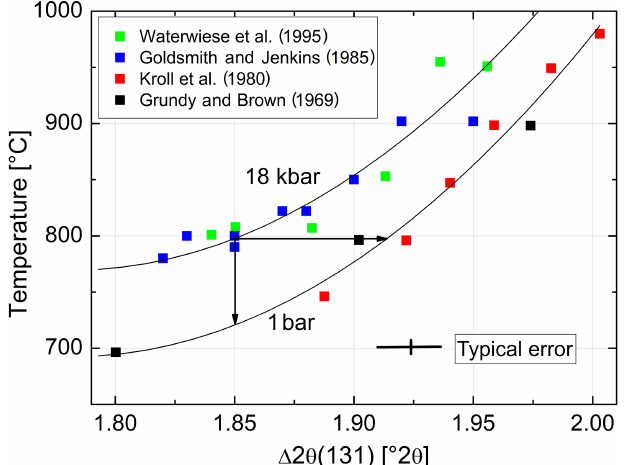
Figure 9. Variation in the thermodynamic order parameter Q od = ( t 1 0 − t 1 m )/( t 1 0 + t 1 m ) in Na-feldspar in equilibrium with temper- ature and pressure. Straight lines are drawn to guide the eye; the left ones refer to ambient pressure, and the right ones refer to 18kbar. The dotted curve is taken from Salje et al.